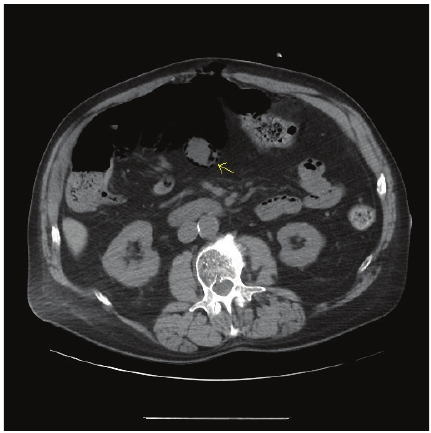
Figure 3: A CT image of dependent air in the bowel wall of Patient